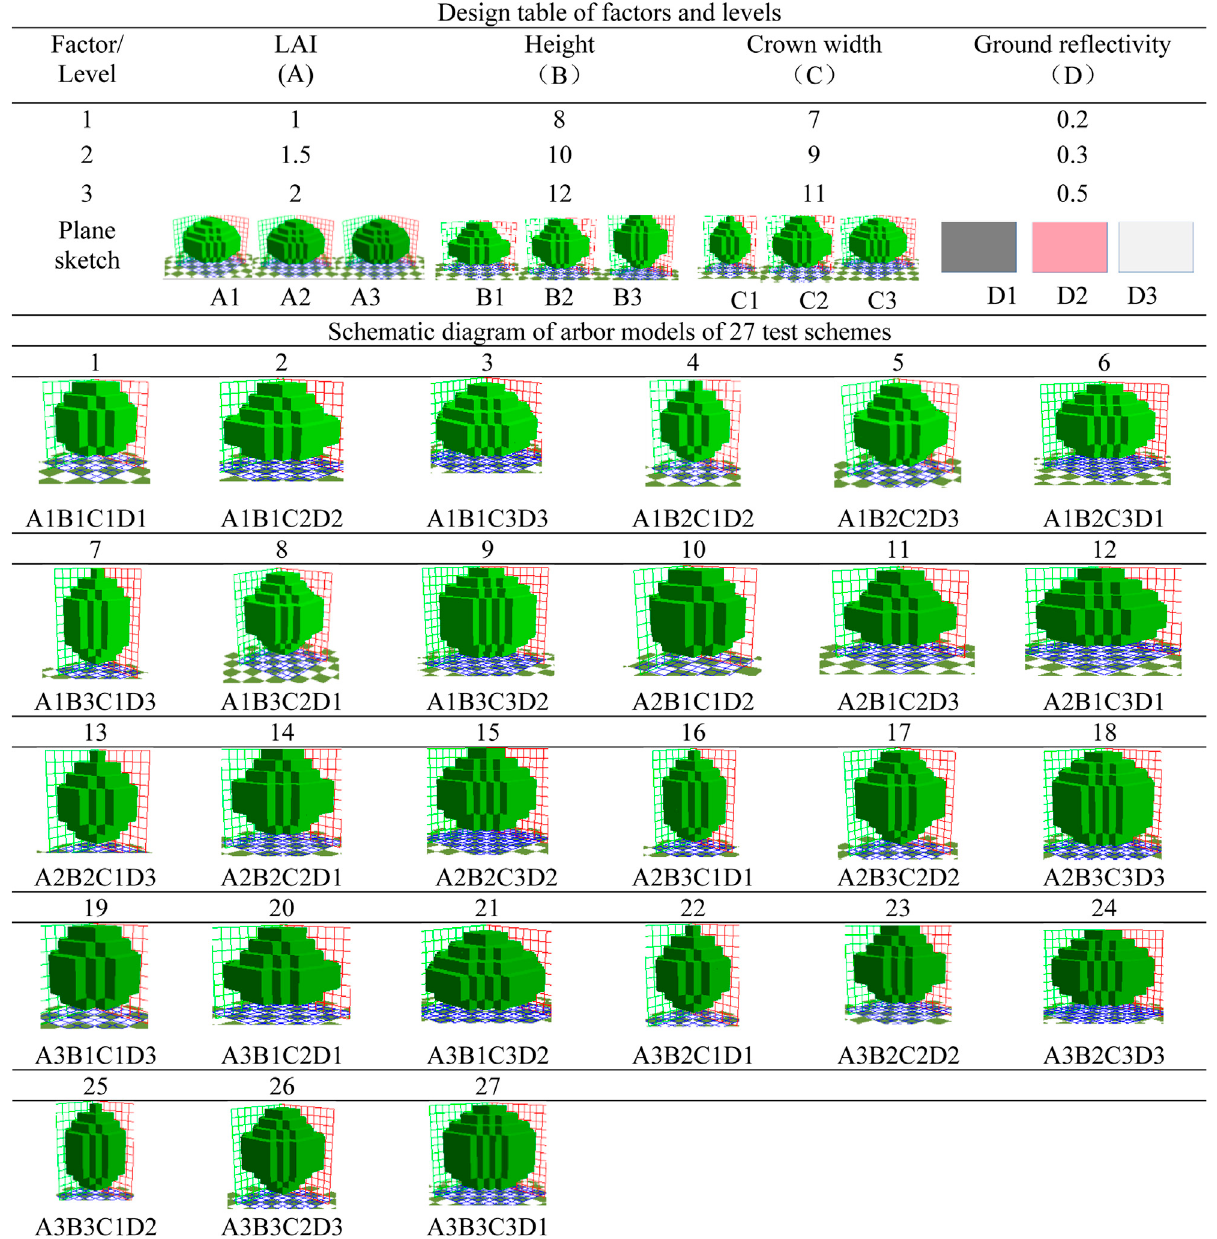
TABLE 7 The information of orthogonal